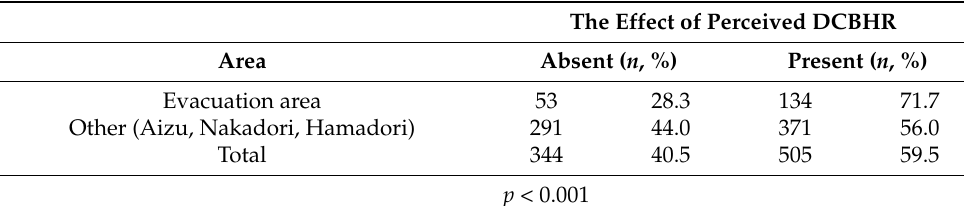
Table 2. The distribution of responses to the question on the effect of perceived